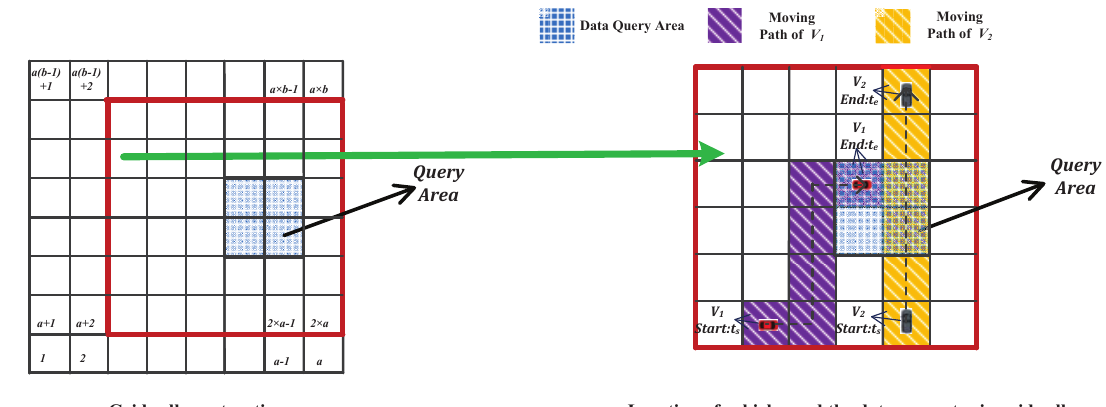
Figure 3. Defined grid cell architecture/locations of vehicles and the data query area in grid